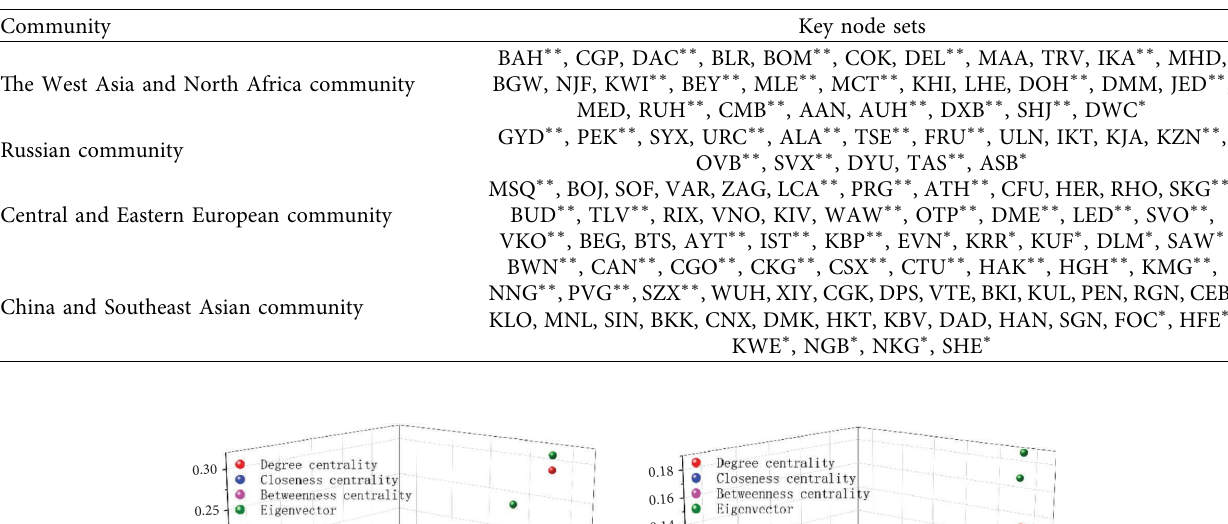
Table 5: Key node identifcation results of community network.